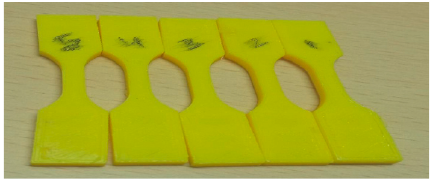
Figure 2: Printed tensile specimens.